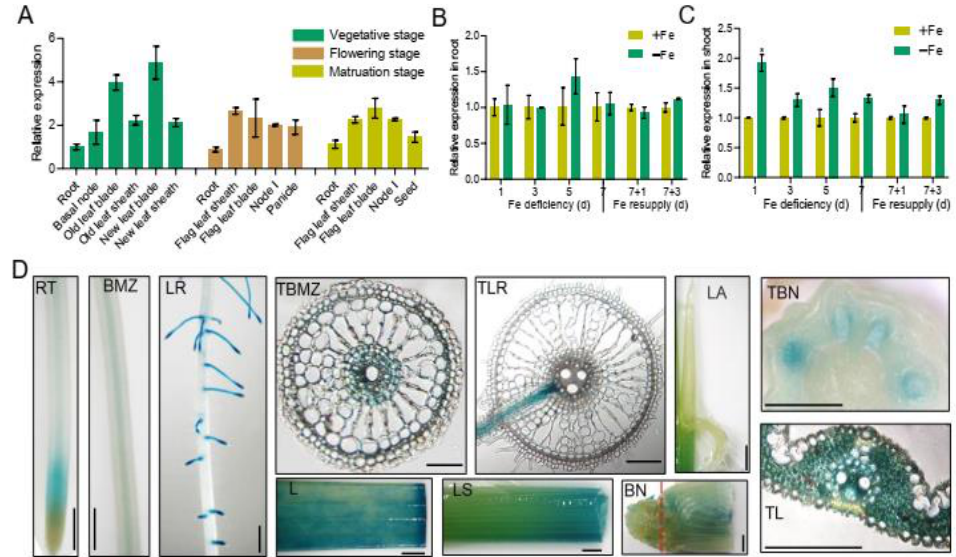
Figure 1. Expression profiling of OsbHLH057 in rice. ( A ) Reverse transcription quantitative PCR (RT-qPCR) analysis of the expression levels of OsbHLH057 in various rice tissues of different growth stage. ( B , C ) RT-qPCR analysis of the expression levels of OsbHLH057 in the root ( B ) and shoot ( C ) under different Fe supply conditions. ( D ) GUS staining of various tissues in ProOsbHLH057::GUS transgenic plants, including root tips (RT), basal mature zone of root (BMZ), lateral roots (LR), transverse section of BMZ (TBMZ), transverse section of TR (TLR), leaf (L), leaf sheaths (LS), ligule and auricle (LA), basal node (BN), transverse section of BN (TBN), and transverse section of L (TL). Red line in BN indicates the place of section. Scale bars = 50 µ M in TBMZ, TLR, and TL; Scale bars = 1 mm in other